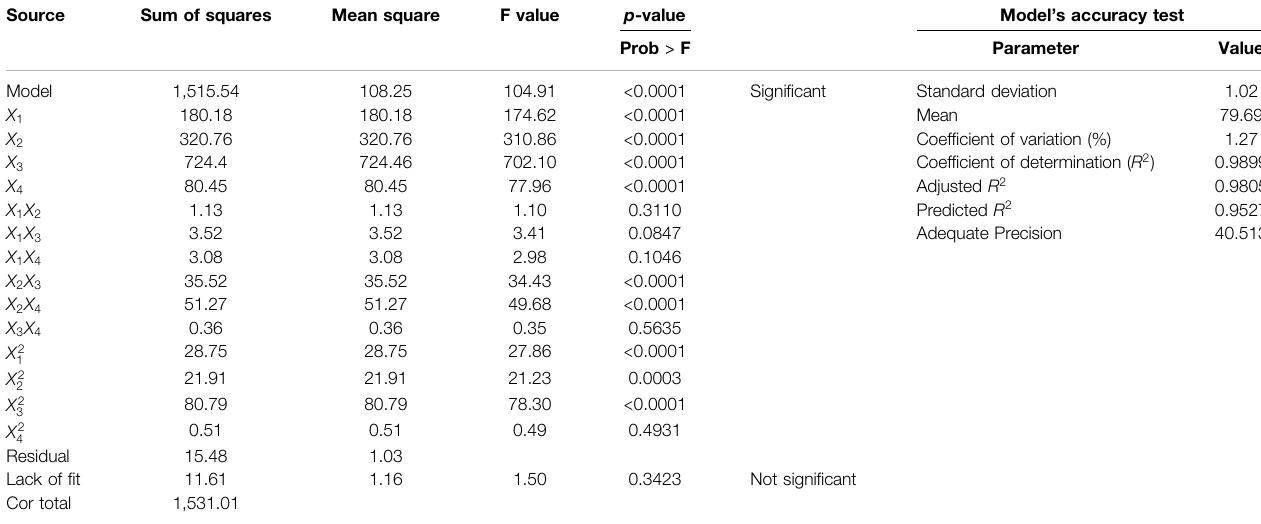
TABLE 4 | Comparison between different heterogeneous catalysts and biodiesel yields. Oil feedstock Catalyst